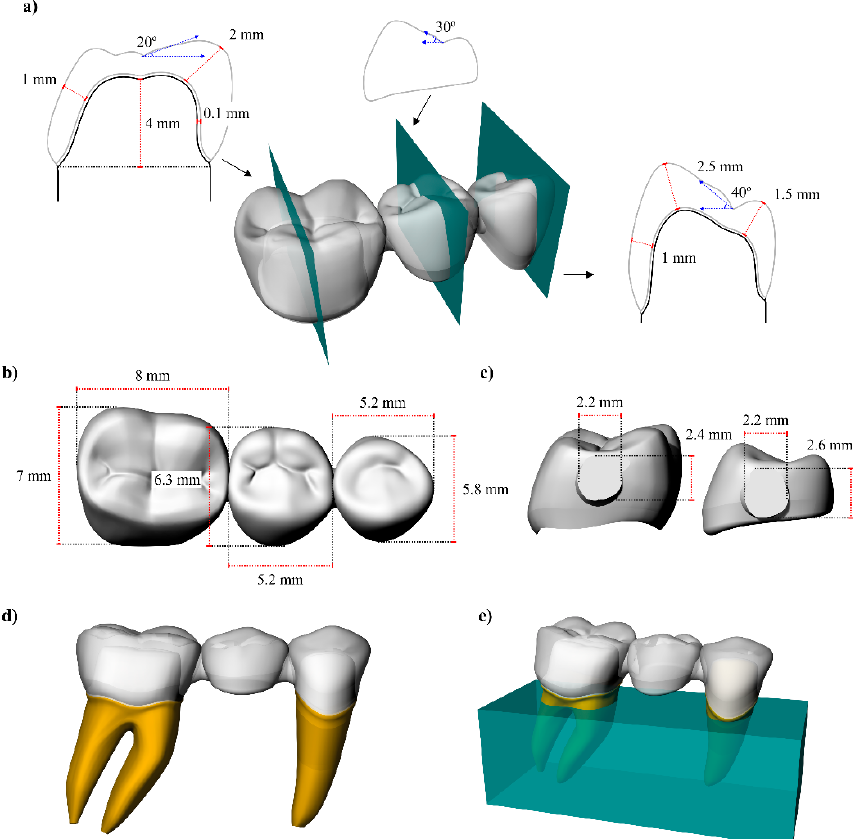
Figure 1. Three-dimensional modeling of fixed partial dentures in the computer-aided design software. ( a ) Section planes with each tooth profile and dimensions, ( b ) mesiodistal and buccolingual teeth dimension, ( c ) mesial and distal connectors height and width, ( d ) fixed dental prosthesis in position and ( e ) support model.